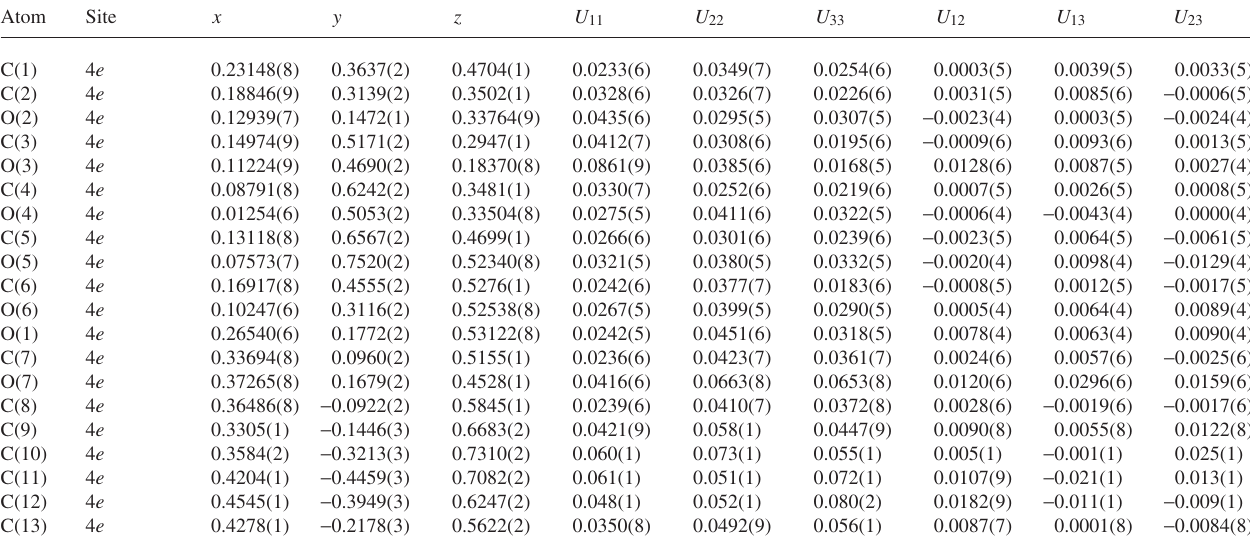
Table 3. Atomic coordinates and displacement parameters (in Å 2 )